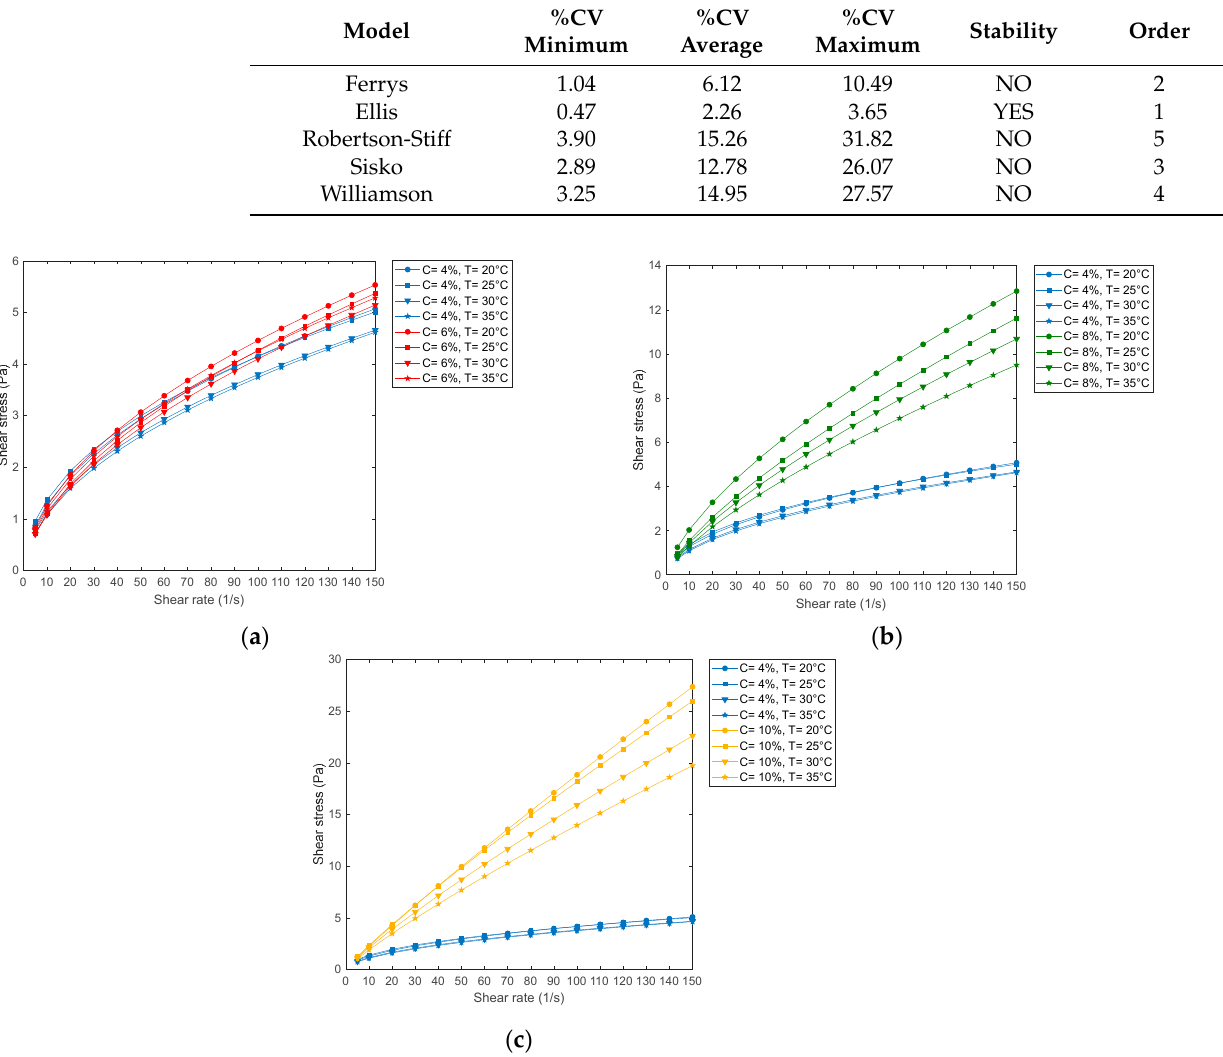
5%, both for the minimum and maximum values. The foregoing agrees with what is